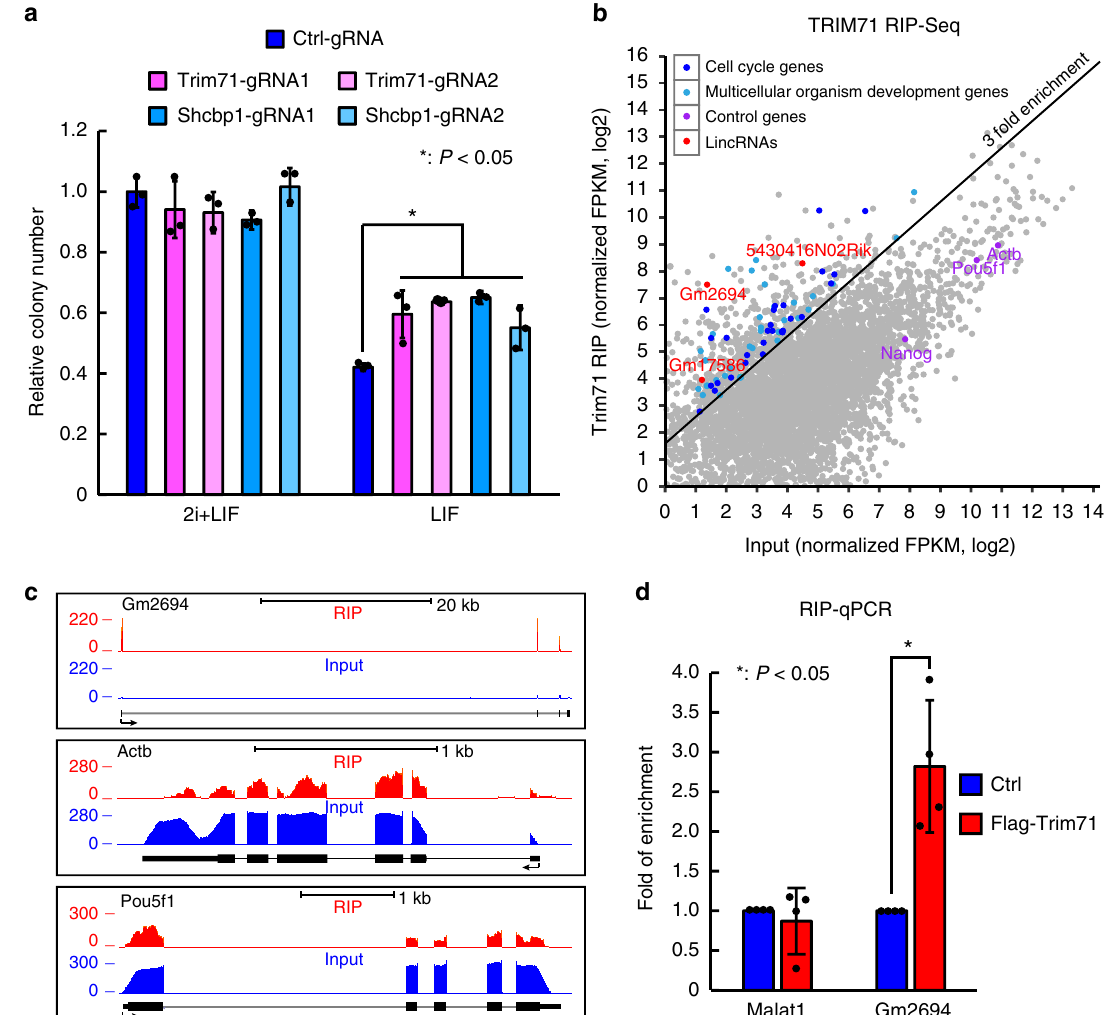
Fig. 1 Trim71 promotes FGF/ERK signaling and binds lncRNA Trincr1 in ESCs. a Colony formation assay for ESCs treated with control, Trim71, and Shcbp1 CRISPRi gRNAs. For the LIF condition, cells were plated in 2i + LIF medium for 1 day, then changed to N2B27 supplemented with LIF for 4 days before being re-plated in 2i + LIF medium for colony formation. Data were normalized to ESCs treated with control gRNAs grown in 2i + LIF. n = 3 biological replicates. b RIP-Seq analysis showing average-normalized, log2 transformed FPKM value of Flag-Trim71-RIP and input. c RIP-Seq tracks at the Gm2694, Actb, and Oct4 (also known as Pou5f1) loci. Shown are normalized read counts per million. Flag-Trim71-RIP and input were scaled to the same level. d RIP followed by RT-qPCR analysis of Malat1 and Gm2694. Data were normalized to ESCs transfected with empty 3XFLAG overexpression vectors (Ctrl). n = 4 independent experiments. Shown are mean ± SD. For a , P values were determined by unpaired two-way ANOVA with two-sided Dunnett ’ s test. For d , P values were determined by paired two-sided Student ’ s t